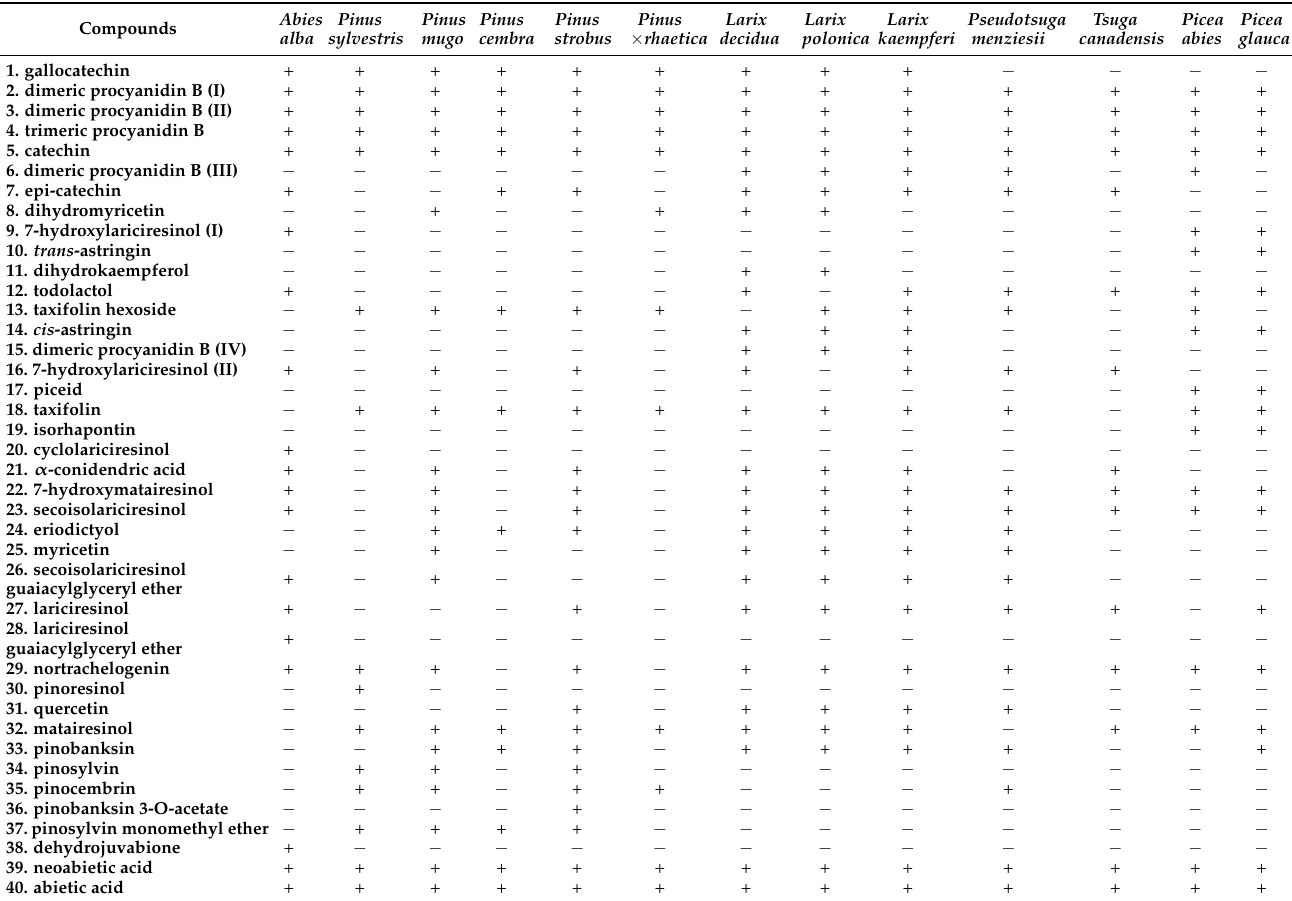
Table 2. Presence of compounds confirmed through LC-DAD–ESI-MS/MS analysis in Pinaceae